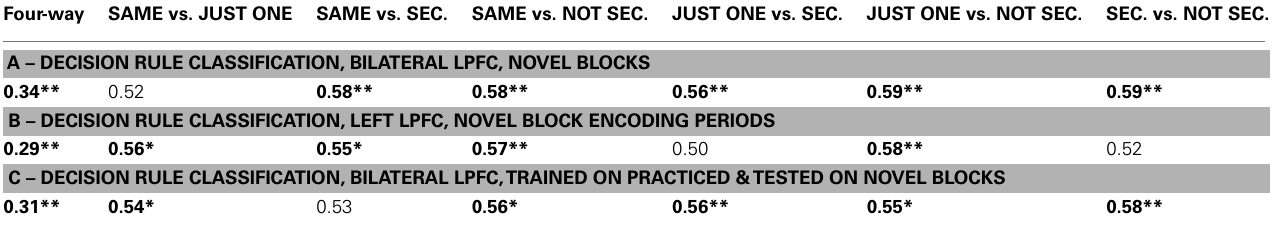
Table 4 | Lateral prefrontal cortex four-way and pair-wise decision rule classification